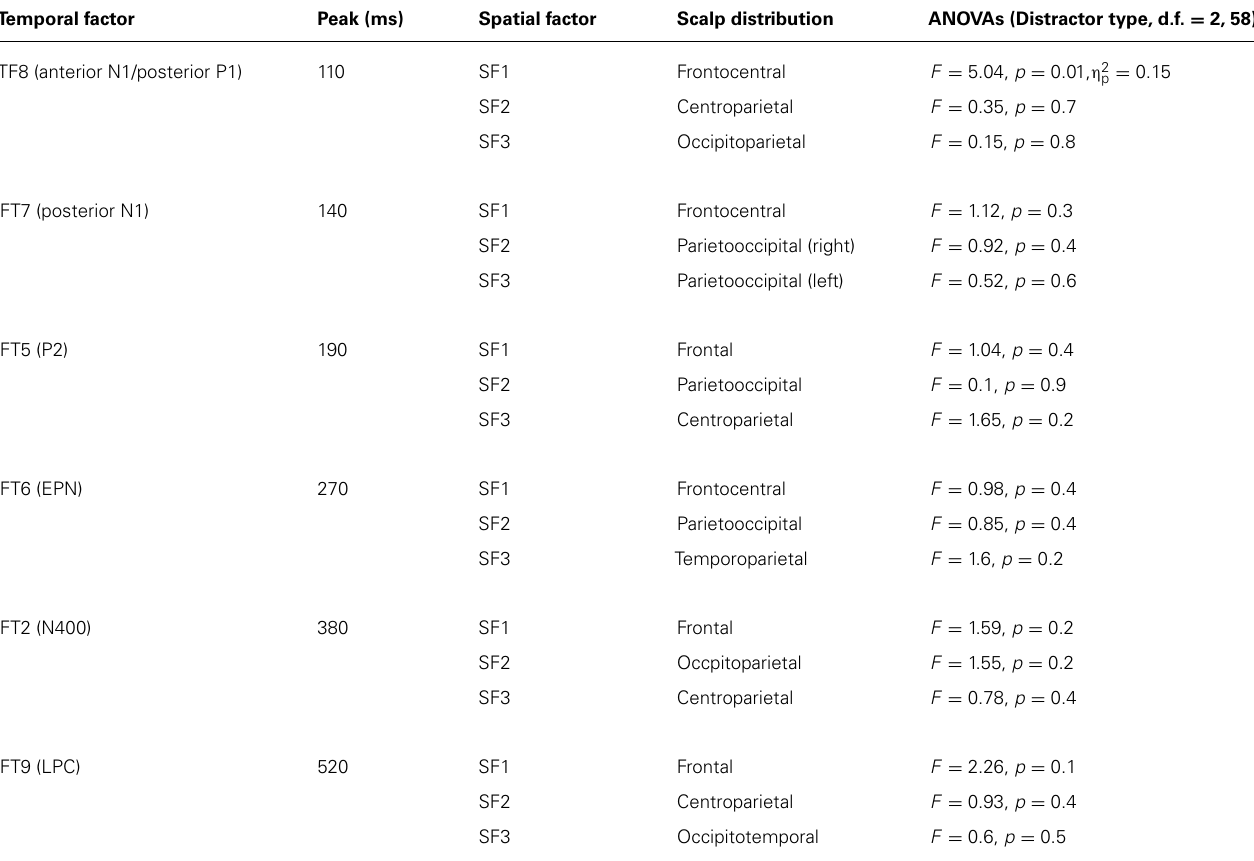
Table 3 | Description and statistical results for the factors extracted by temporospatial principal component analysis. Temporal factor Peak